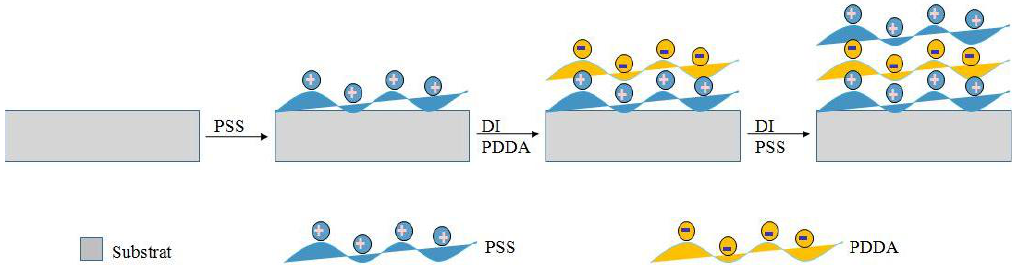
Figure 2. Polyelectrolyte LbL assembly surface treatment.